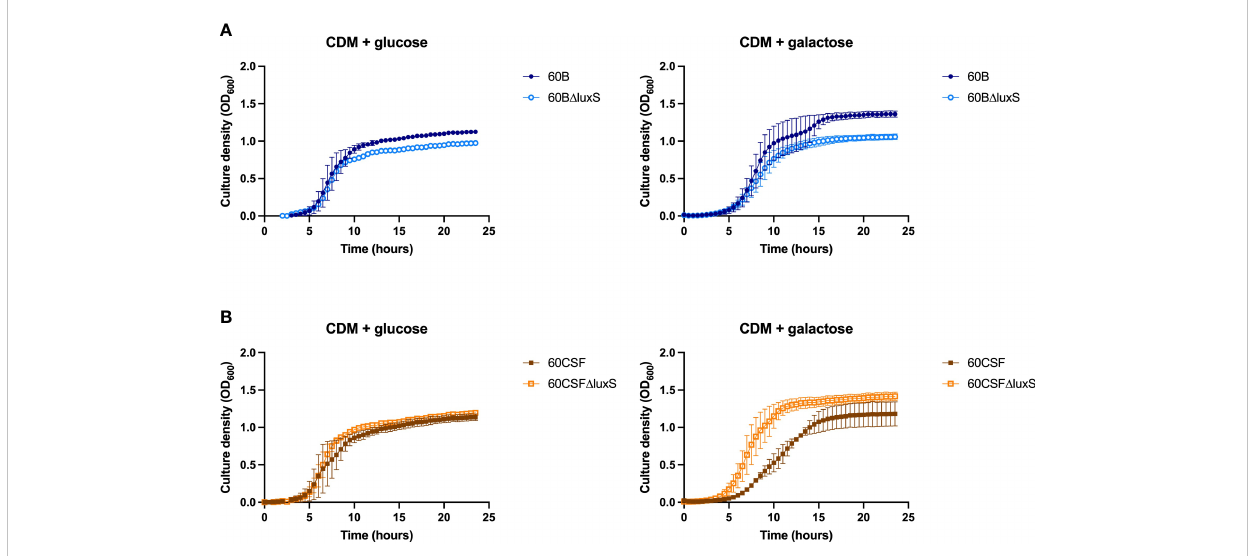
FIGURE 4 Growth of 60B, 60CSF and luxS mutants in CDM + glucose and CDM + galactose. 60B and its luxS mutant 60B D luxS (A), and 60CSF and its luxS mutant 60CSF D luxS (B) were grown in 200 µL CDM supplemented with 0.5% glucose (CDM + glucose) or 0.5% galactose (CDM + galactose). OD 600 was measured every 30 min for 24 (h) Data are mean OD 600 ± standard error mean (SEM) from two independent assays, each performed in